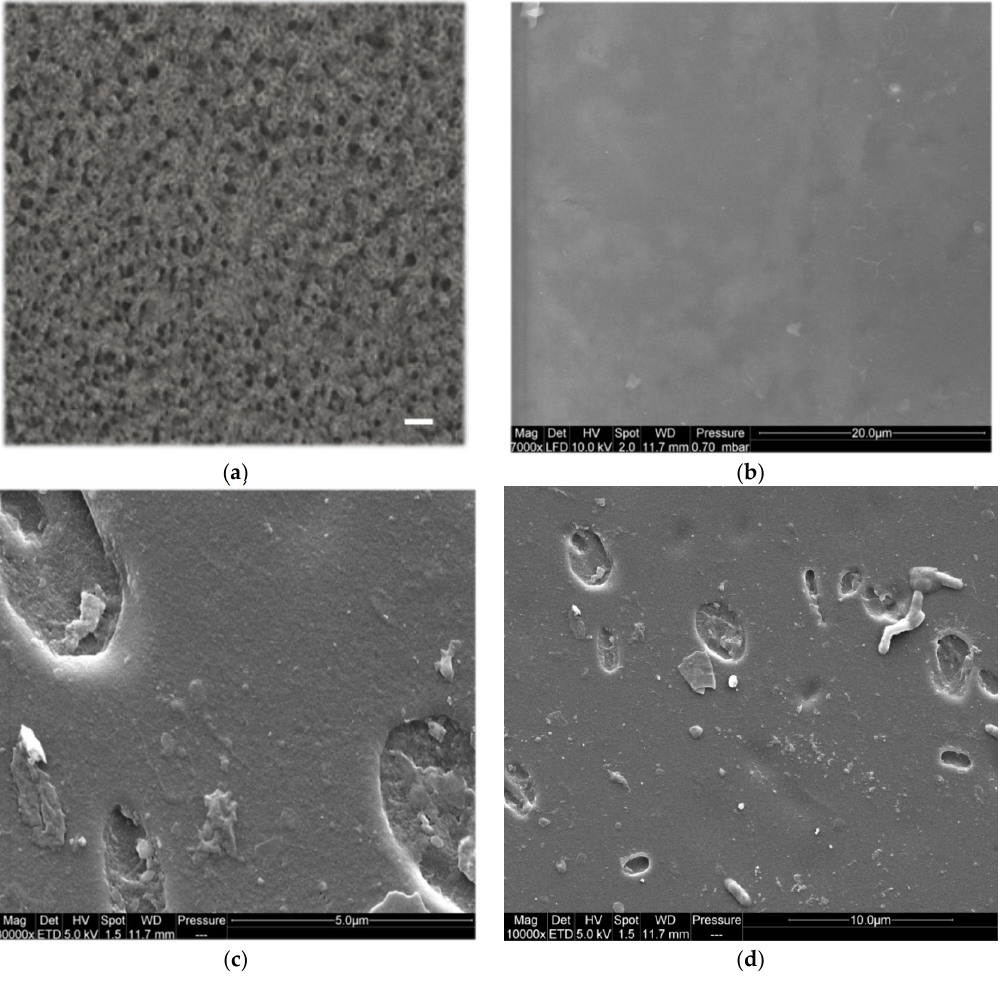
Figure 6. ( a ) Light microscopy image of the keratin film obtained after three days of dialysis, scale bar: 5 µ m; ( b – d ) ESEM (sodium dodecyl sulphate polyacrylamide gel electrophoresis) images of keratin film obtained after 14 cycles of diafiltration imaged under low vacuum conditions; ( b )